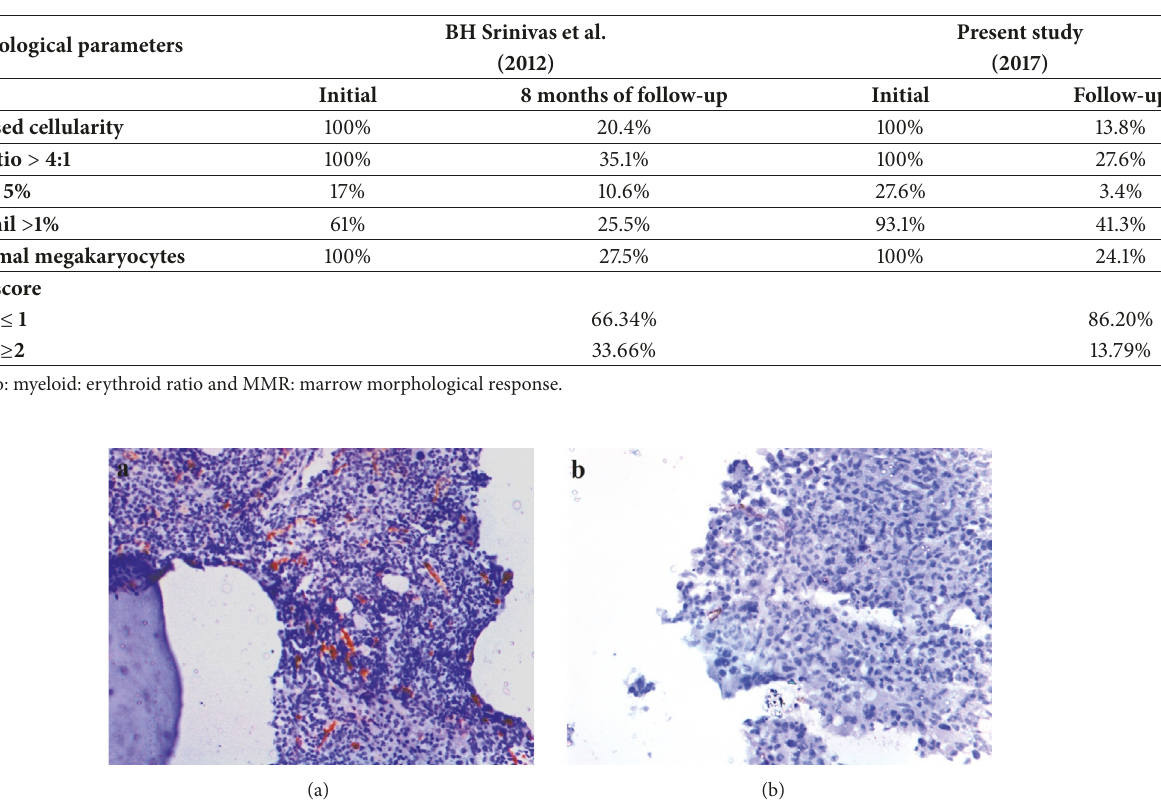
Figure 4: (a) Pre therapy immunohistological section of bone marrow biopsy stained for CD34 (400x magnification) showing microvessels with or without lumen which are stained in brown (mean MVD = 24). (b) Post therapy immunohistological section of bone marrow biopsy of same patient showing reduced number of microvessels (mean MVD =